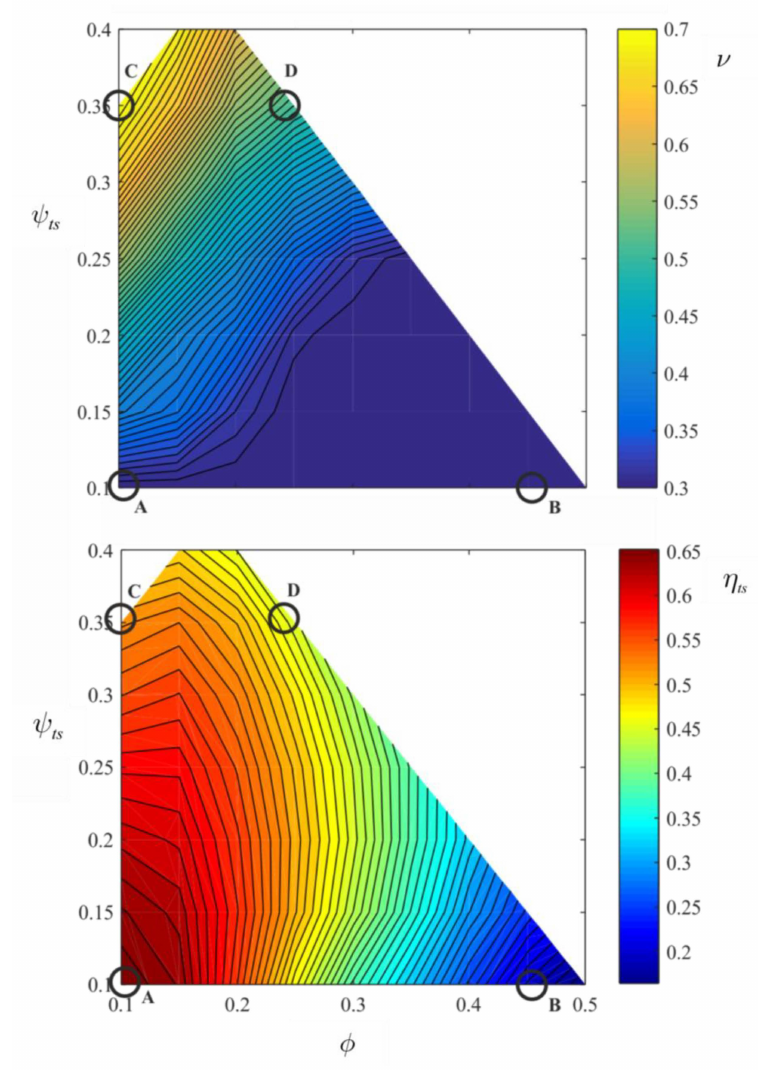
Figure 6. Upper: hub-to-tip ratios of optimal impellers; lower: total-to-static efficiencies of these impellers; the design points denoted with letters refer to Table